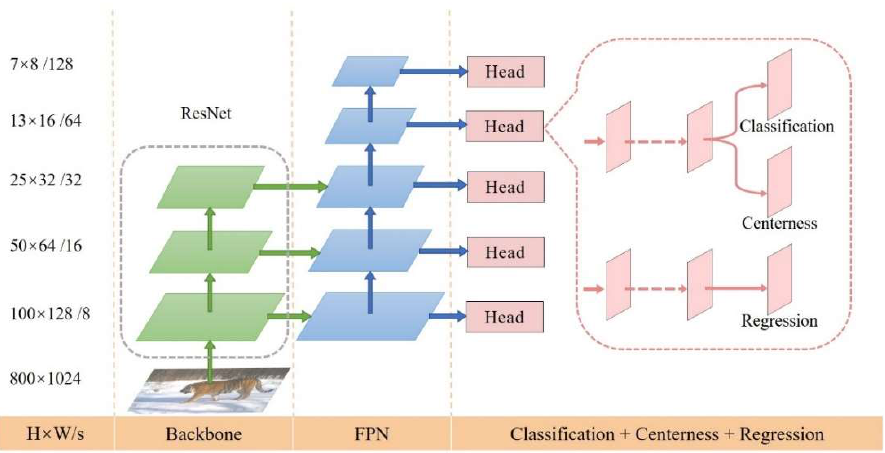
Figure 3. FCOS structure diagram. H × W is the height and width of feature maps. ‘/s’ (s = 8, 16, …, 128) is the downsampling ratio of the feature maps at the level to the input image [35].